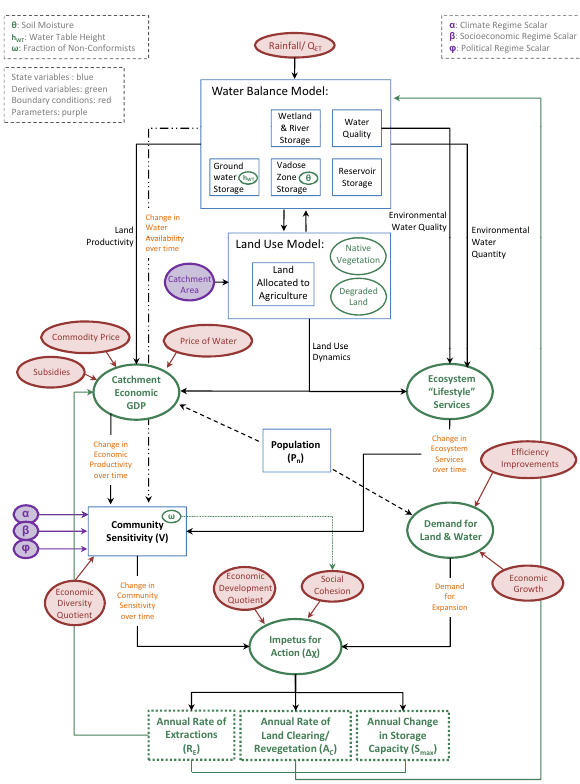
Figure 3. A generic socio-hydrology conceptual framework for ap- plication to agricultural